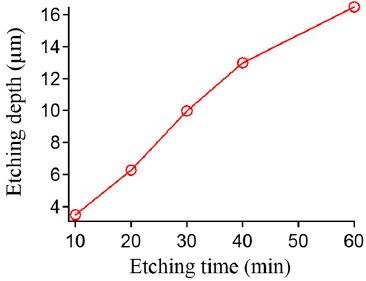
Figure 8. Glass etching depth as function of etching time.